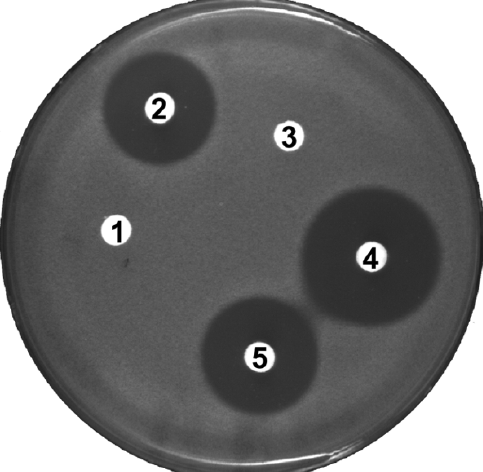
Figure 4. Bioassay to test tacrolimus antioxidant activity. 1 —35 µg (200 nmol) ascorbic acid; 2 —1 µg (1.24 nmol) tacrolimus + 4 µmol H 2 O 2 ; 3 —1 µg (1.24 nmol) tacrolimus; 4 —4 µmol H 2 O 2 ; 5 —35 µg (200